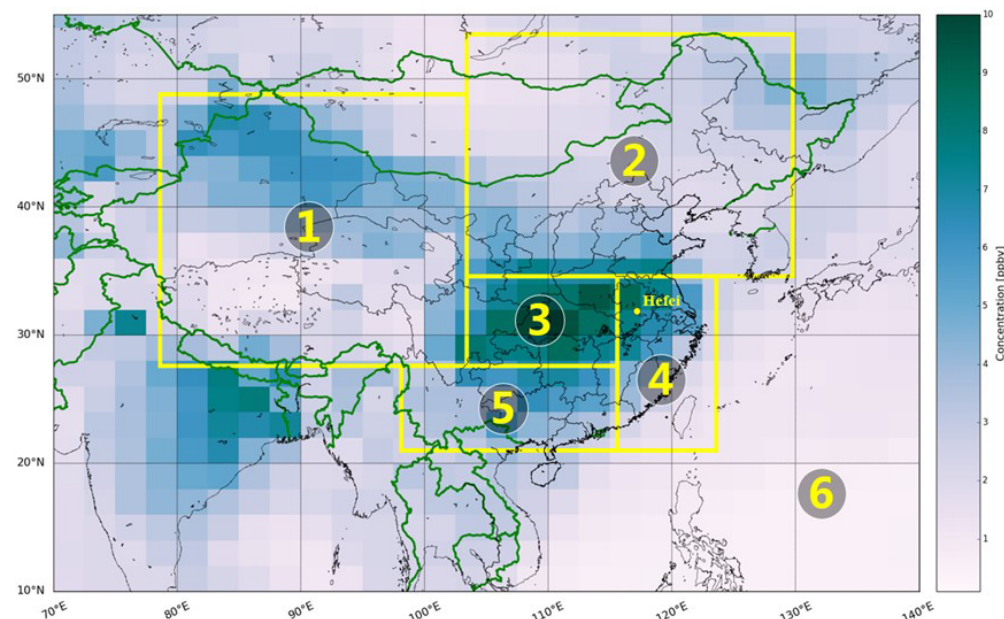
Figure 2. Geographical regions used for GEOS-Chem sensitivity simulations. The numbers (cid:192) – (cid:197) represent western, northern, central, east- ern, and southern China, and the rest of world, respectively. See Table 3 for latitude and longitude delimitations. Daily mean values of C 2 H 6 troDMF on 1 January 2017 provided by GEOS-Chem BASE simulation were selected as representative of wintertime enhancement in eastern China. The base map of this figure is created by the Python “Basemap”